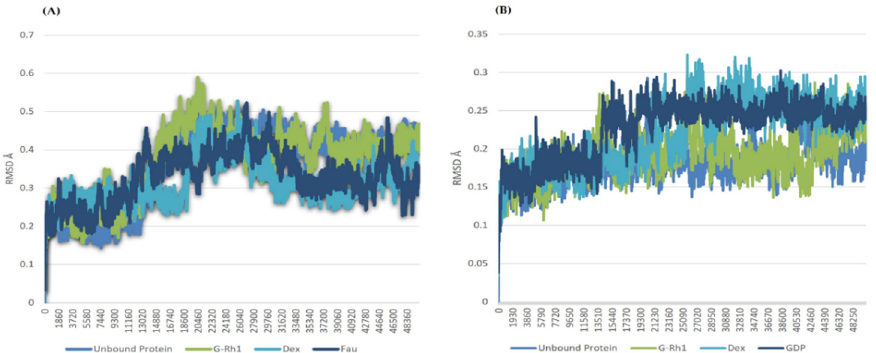
Figure 4. RMSD of ginsenosides Rh1 and control (Dexamethasone, Fausidil) in complex with Figure 4 . RMSD of ginsenosides Rh1 and control (Dexamethasone, Fausidil) in complex with ( A ) ( A ) ROCK1 and ( B ) G-Rh1 and control (Dexamethasone, GDP) in complex with RhoA as a function Figure 4 . RMSD of ginsenosides Rh1 and control (Dexamethasone, Fausidil) in complex with ( A ) Figure 4 . RMSD of ginsenosides Rh1 and control (Dexamethasone, Fausidil) in complex with ( A ) ROCK1 and ( B ) G-Rh1 and control (Dexamethasone, GDP) in complex with RhoA as a function of ROCK1 and ( B ) G-Rh1 and control (Dexamethasone, GDP) in complex with RhoA as a function of ROCK1 and ( B ) G-Rh1 and control (Dexamethasone, GDP) in complex with RhoA as a function of of MD simulation time. MD simulation time. MD simulation time. MD simulation time.